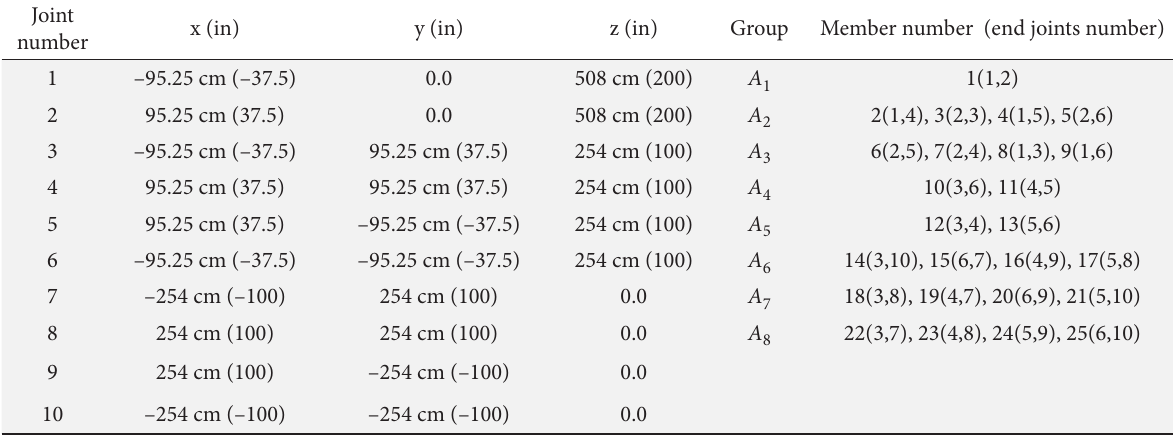
Table 6. Initial layout and member grouping for the spatial 25-bar truss problem